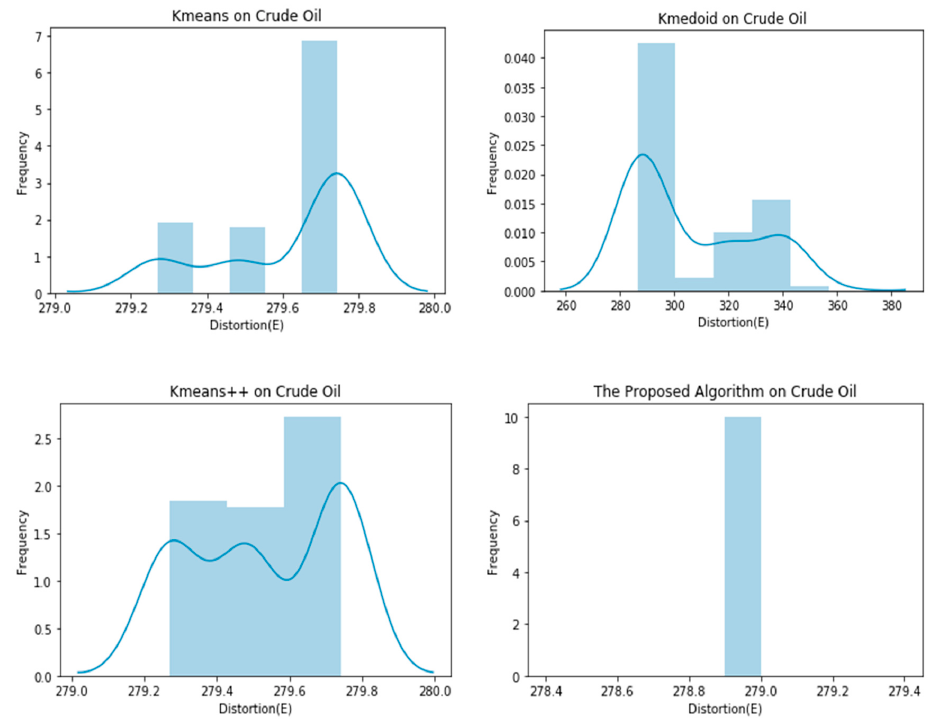
Figure 8. Graphical representation of E obtained by 100 runs of di ff erent algorithms on the Crude Oil dataset.